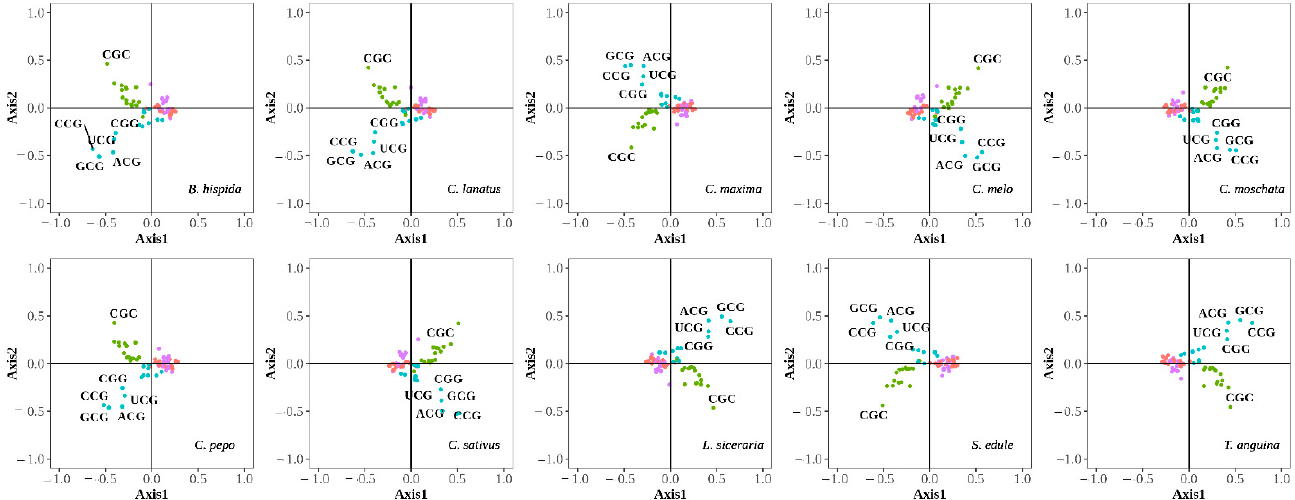
Figure 4. Correspondence analysis of CUB of ten species of Cucurbitaceae: the distribution of codons is shown along the first and second axes. Note: The red, green, blue, and purple dots represent the codons ending with A, C, G, and U. The outlier points are marked with the names of the corresponding codons.